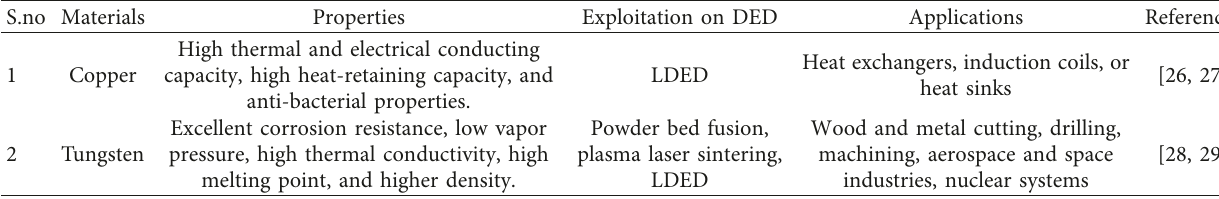
Table 3: Types of feed materials (pure metals).